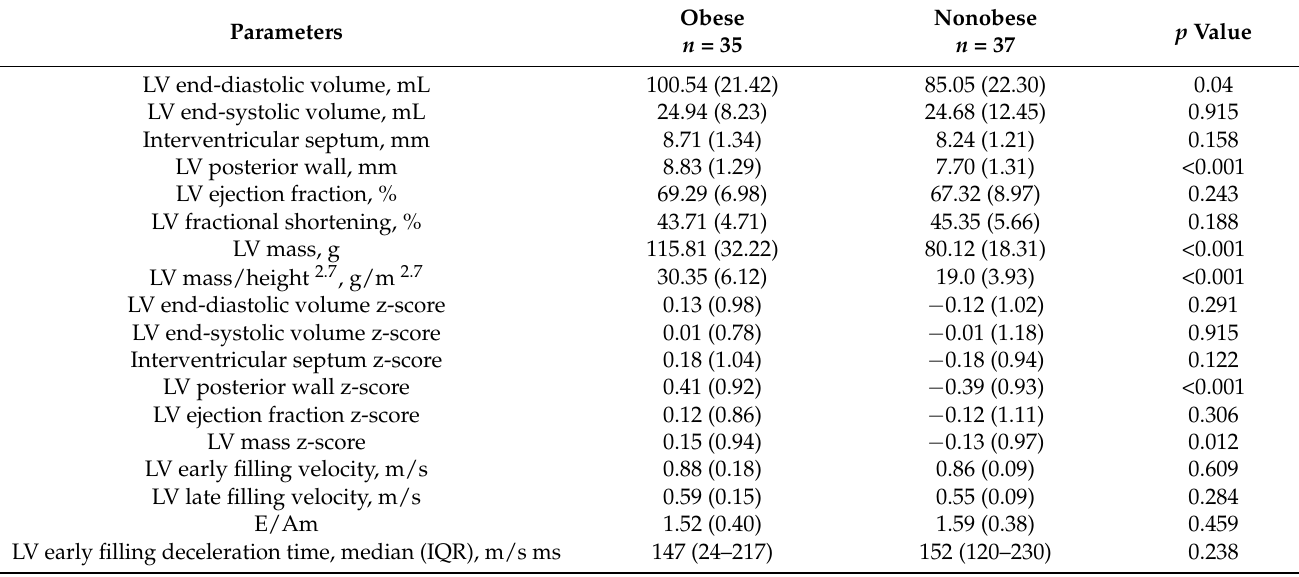
Table 2. Conventional and Doppler echocardiographic